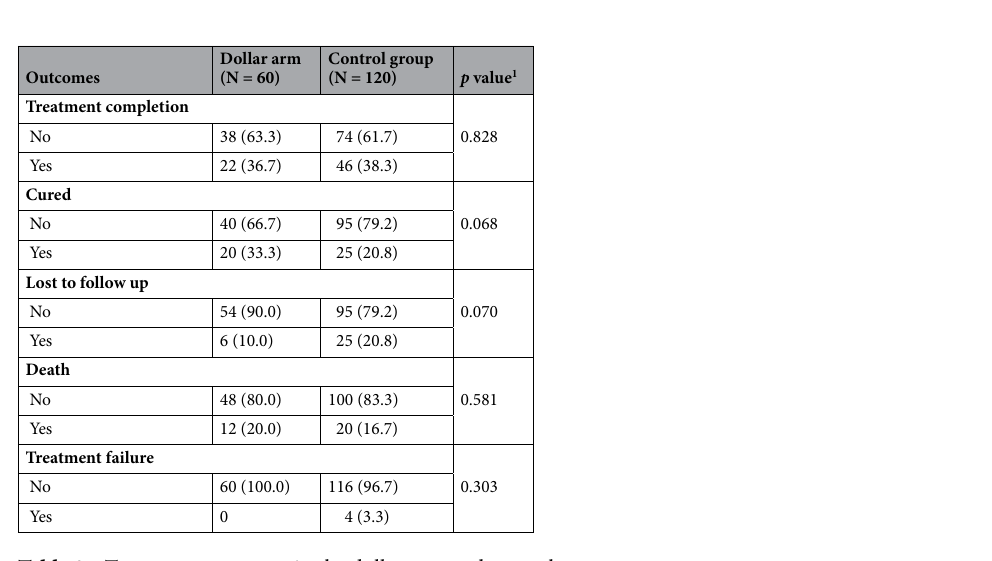
Table 3. Treatment outcomes in the dollar arm and control